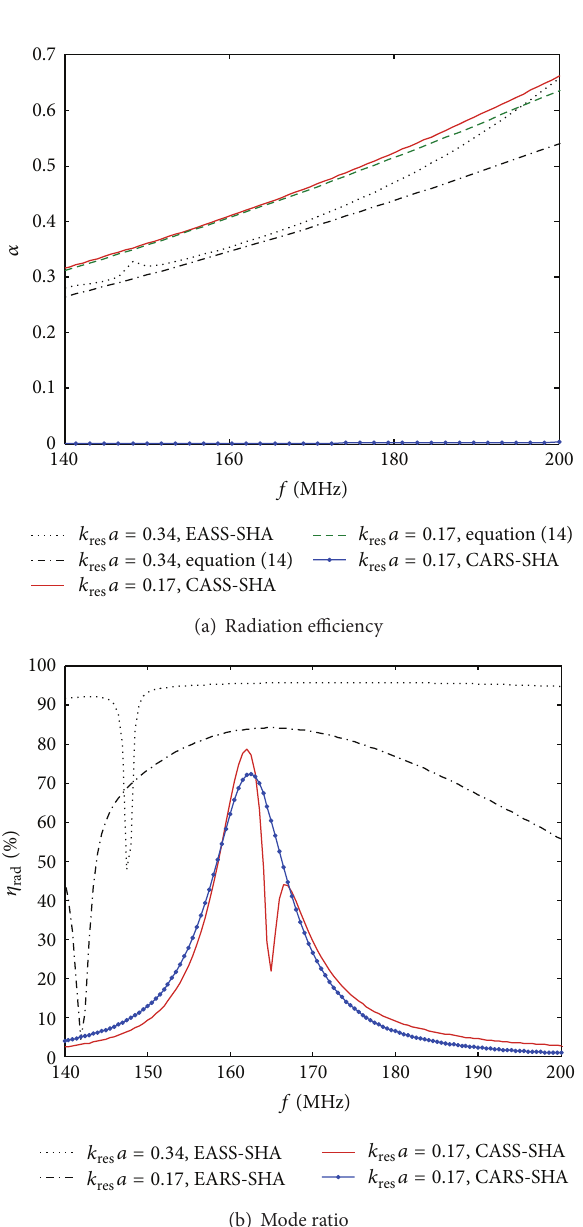
Figure 7: Radiation properties of examined SHAs from Table 2 versus